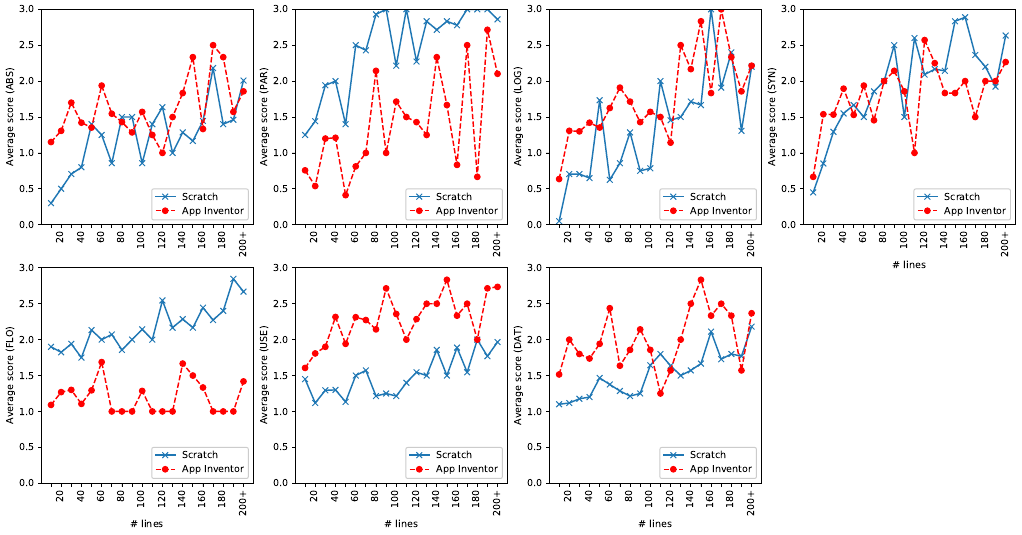
Figure 4. The average scores of each computational thinking concept according to the number of lines of code. ABS, PAR, LOG, SYN, FLO, USE, and DAT correspondingly denote Abstraction and Problem Decomposition, Parallelism, Logical Thinking, Synchronization, Flow Control, User Interactivity, and Data Representation,